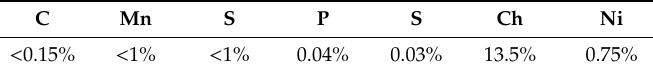
Table 2. Composition of AISI 410